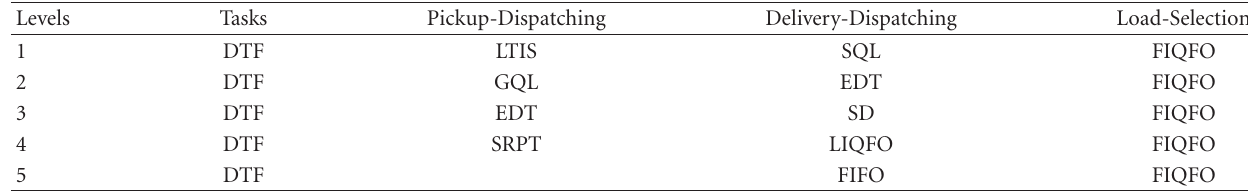
Table 2: The levels of controlling strategies.